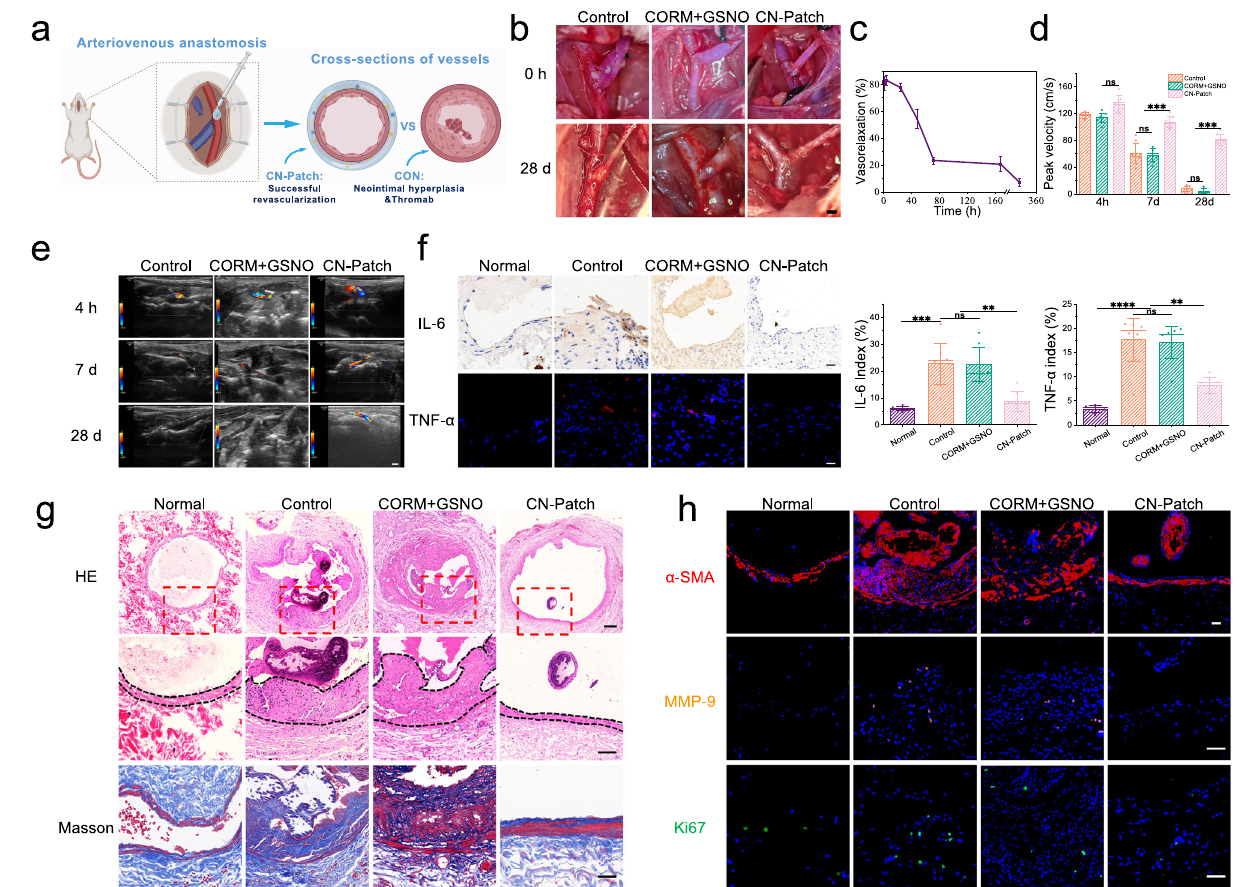
Fig.5|ApplicationoftheCN-Patchforimprovingvascularpatencyofthemain blood vessel after arteriovenous anastomosis. a , b Establishment of the model of carotidarteryto externaljugular vein fi stulainrats. Allrats werethenrandomly dividedintothreegroups,theCN-Patchwasappliedlocallyinthetreatmentgroup, the PBS group was deemed the control group, and CORM+GSNO was a drug solution group with PBSasthe solvent. Scalebar:1mm. Thispicturewas designed using BioRender graphic tool (BioRender.com). c The relaxation capacity of the right external jugular veins under leach liquors of the CN-Patch soaked in PBS was assessed using a DMT wire myograph system (DMT 620) for different periods (mean±SEM, n = 3independentsamples). d , e Thevascularpatencywasevaluated byvisualobservation(0h,28d)andtheultrasounddoppler(4h,7d,and28d),and theaveragepeak fl owvelocityoftheout fl owveinwasrecorded(mean±SEM, n =6 independent samples). Scale bar: 2mm. f Representative